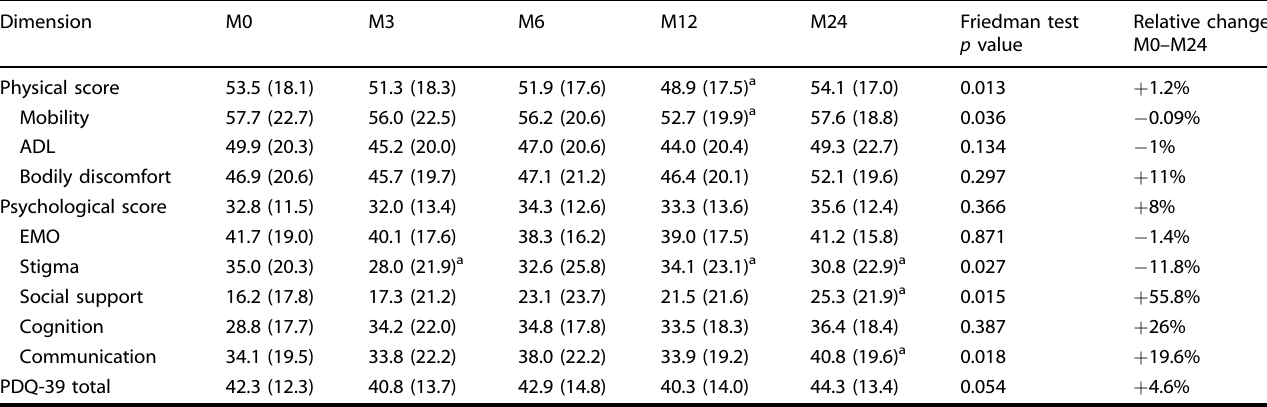
Table 2. Assessment of patient ’ s quality of life measured by PDQ-39 ( n = 57). Dimension